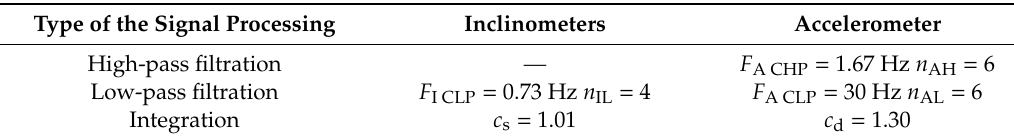
Table 1. The set of optimal parameters of the signals processing.